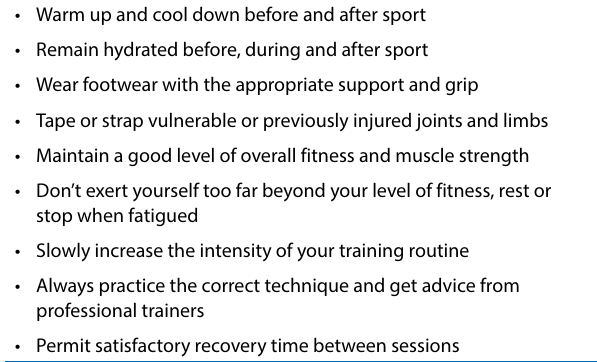
Table 4: Tips on how to prevent sport injuries 9